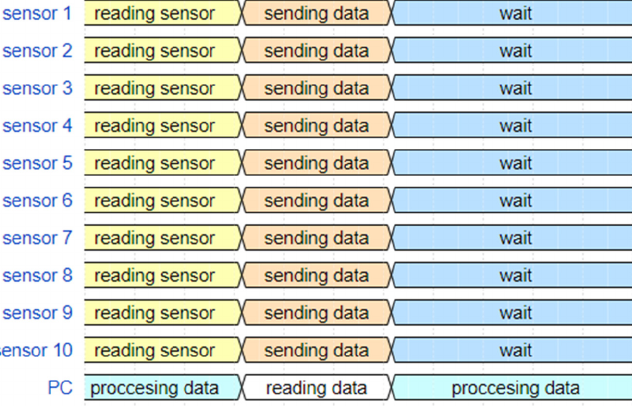
Figure 4. System timing diagram